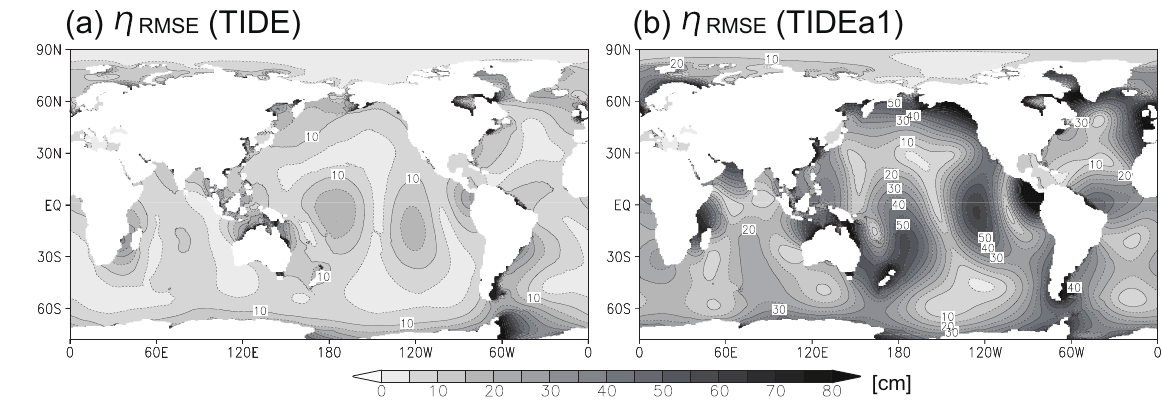
Fig. 5. Root mean square error of the tidal height, η RMSE , in (a) TIDE and (b) TIDEa1. The contour interval is 5cm. over A . The values are 90 % in TIDE, 2 % in TIDEa1,